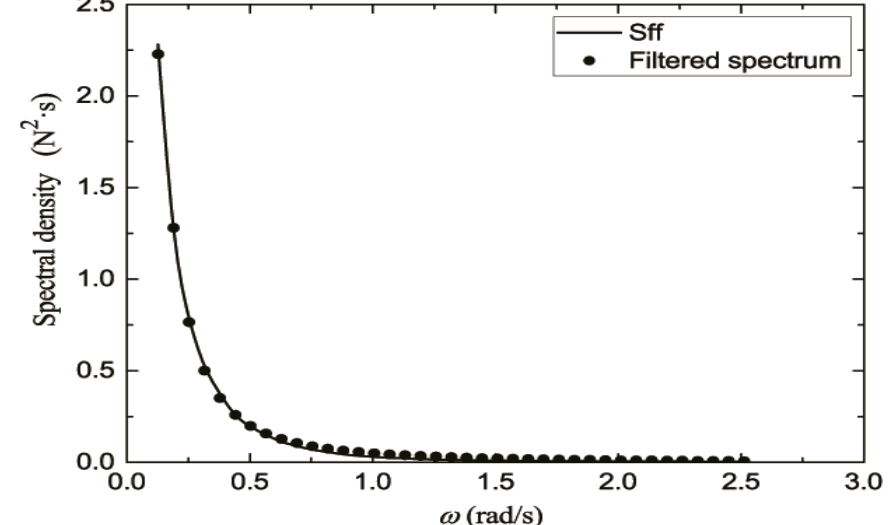
Figure 8. Relative wind excitation spectrum (Sff) and the second-order filtered spectrum for the wind condition of Case 3.